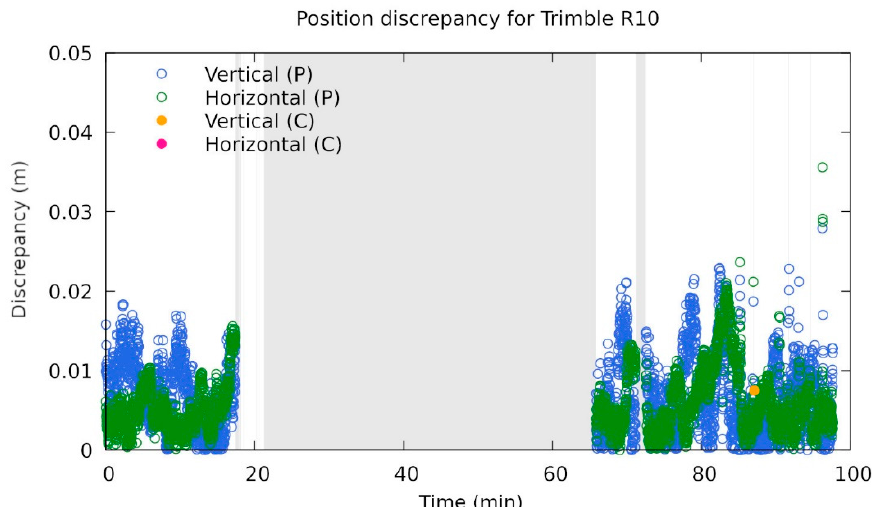
Figure 11. Vertical and horizontal errors during jamming for the Trimble R10 receiver. The time origin was set at 08:20 UTC time. The annotations P and C indicate the type of solution used, namely phase and code, respectively. The grey region represents the interval when no position was given from the receiver (own study).